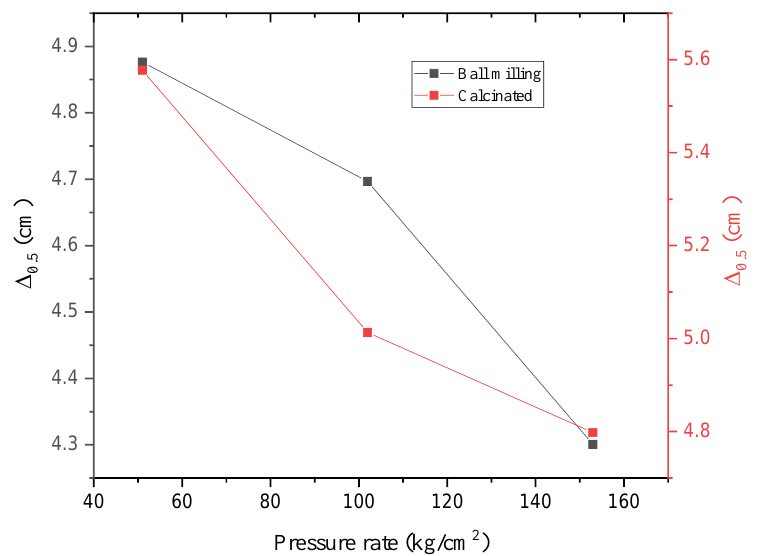
Figure 11. Variation in the Δ 0.5 versus the pressure rate for both calcinated and ball-milled benton- ite.